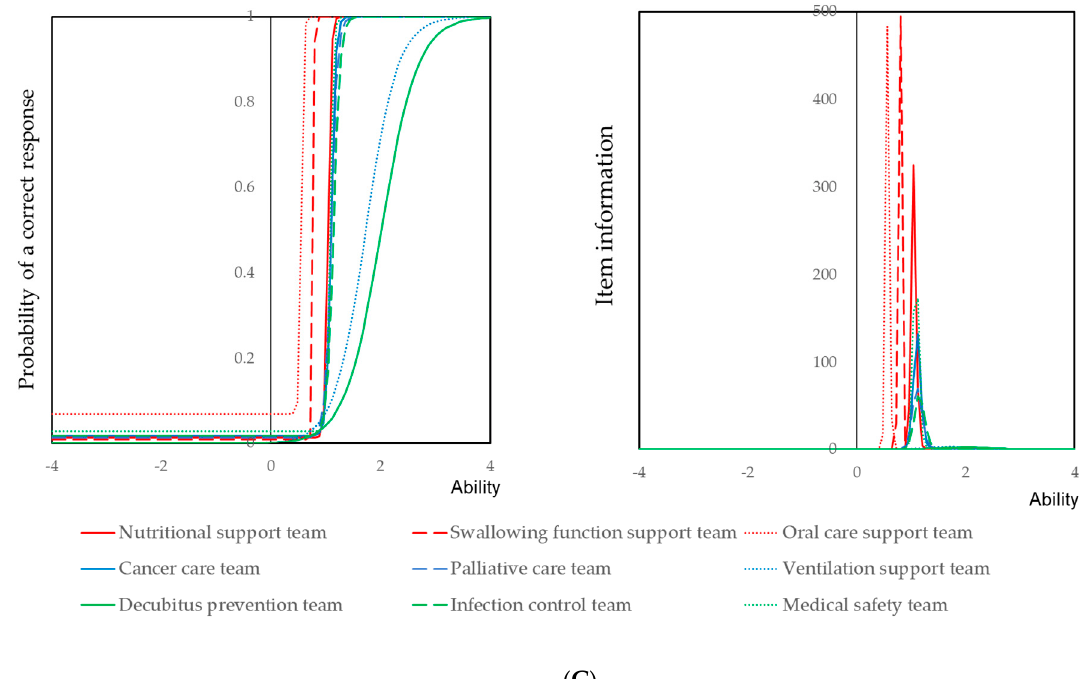
Figure 1. Item response curve and item information curves for the items concerning perioperative oral management. ( A ) Treatments of perioperative oral care management, ( B ) self-assessed perioperative oral care management and ( C ) participation in a medical team. Ability, the scale of the X-axis, represents the weighted score of the total rate of implementation. An item response curve or item information curve with a backward direction indicates that the item was frequently implemented. In contrast, an item response curve with a forward direction indicates that the item was rarely implemented. Steep item response curves and high item information curves indicate that when these items were implemented, other items were easily implemented.